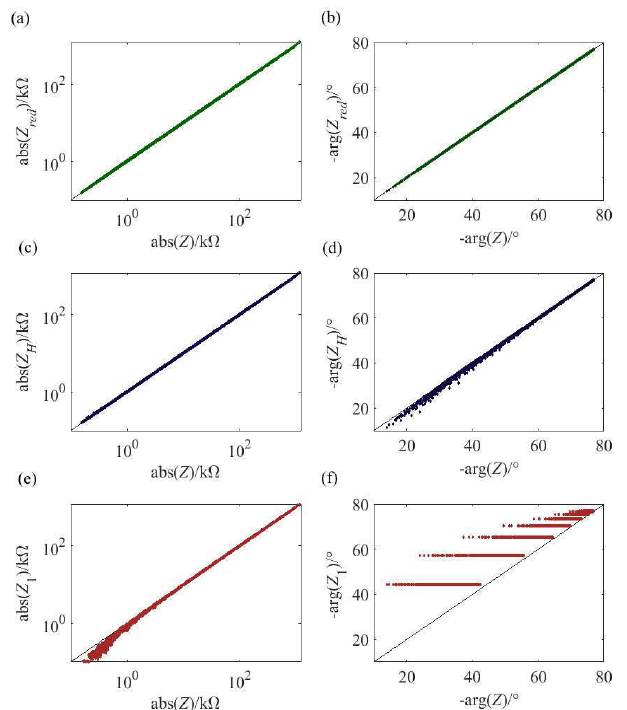
Fig.5: Verification of the magnitude and the phase of the approximate solutions with the full set of equations for the large parametric study: (a-b) reduced model, Z red , solved numerically; (c-d) solution, Z H , from the Hankel transform; (e-f) solution, Z₁, for C ≪